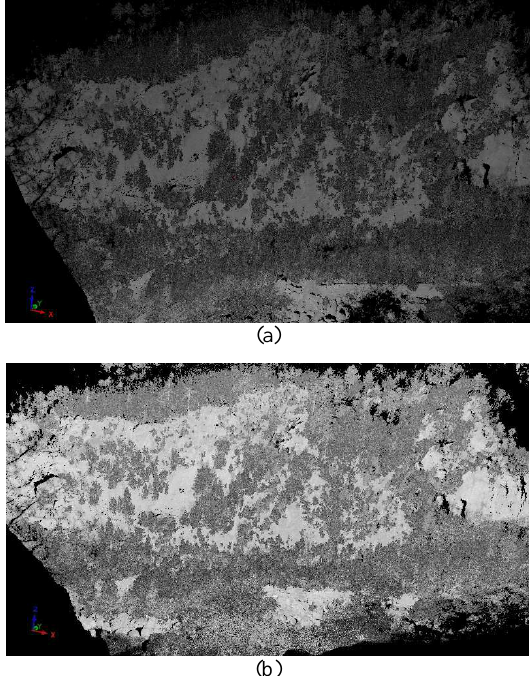
Figure 3: Front view of the test area rendered according to the calibrated amplitude (a) and the calibrated reflectance (b).